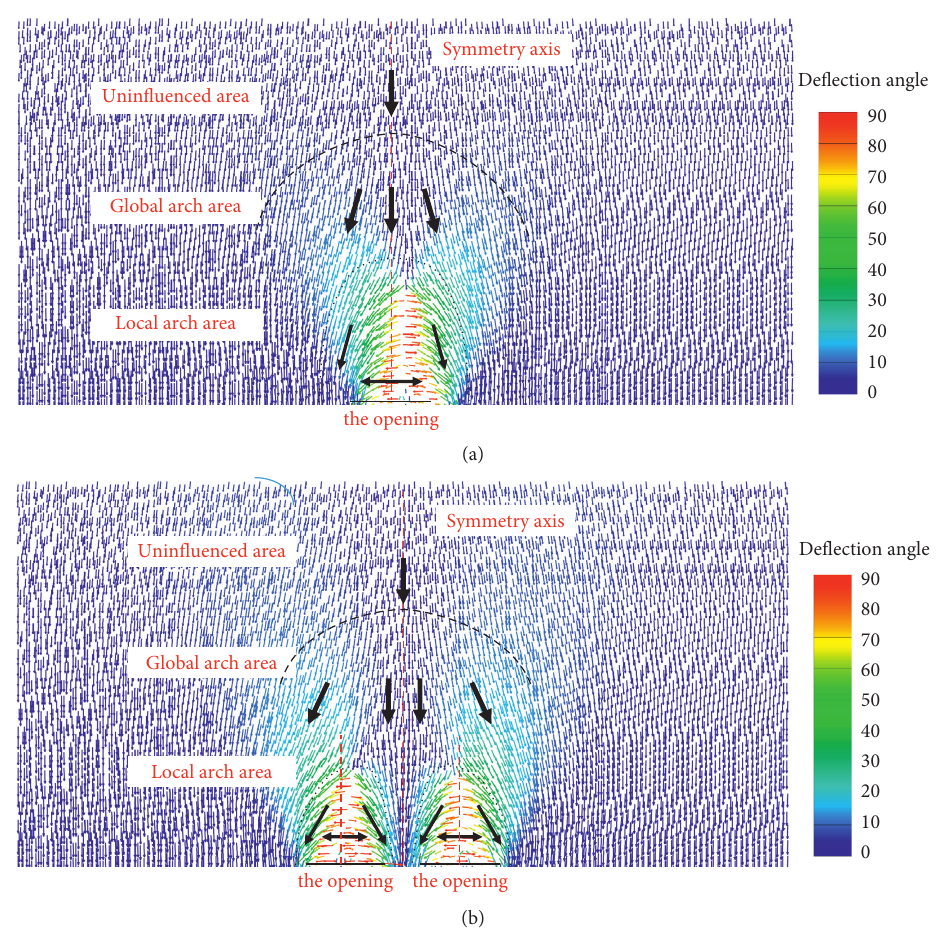
Figure 2: The maximum principal stress vector after excavation. (a) Case a1, single opening; (b) Case a2, twin-parallel opening.